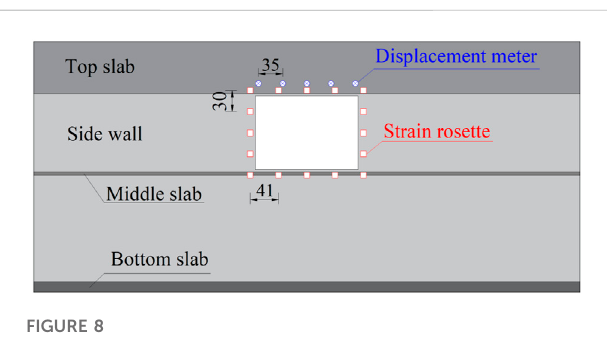
FIGURE 8 Layout of displacement and strain measurement points (mm).